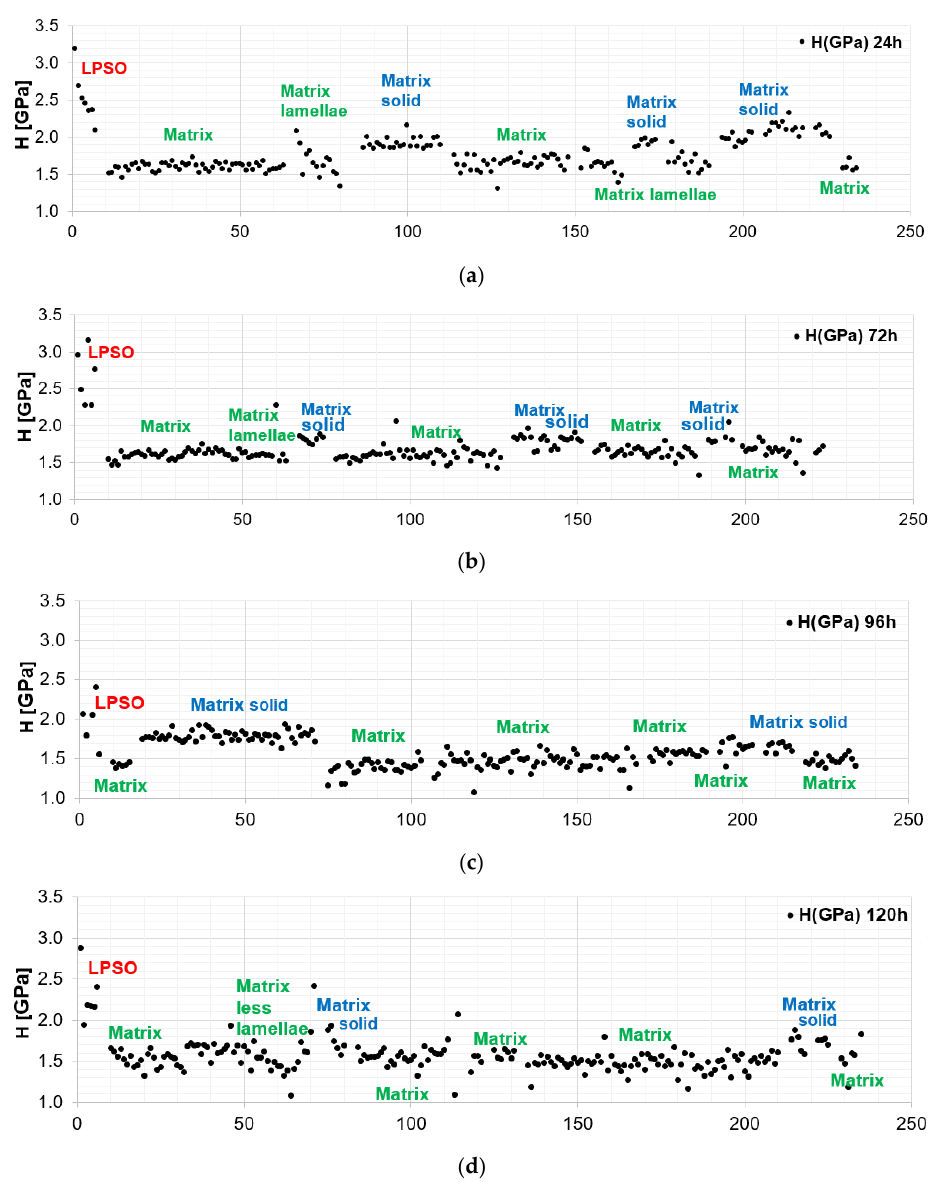
Figure 5. Nanohardness of individual indents organized according to the grains and locations they belong to. The first classified group comprises indents (<10) within the blocky LPSO phases, followed by Mg grains without LPSO lamellae (Matrix solid) and Mg matrix with LPSO lamellae, at different heat treatment durations: ( a ) 24 h, ( b ) 72 h, ( c ) 96 h and ( d ) 120 h.